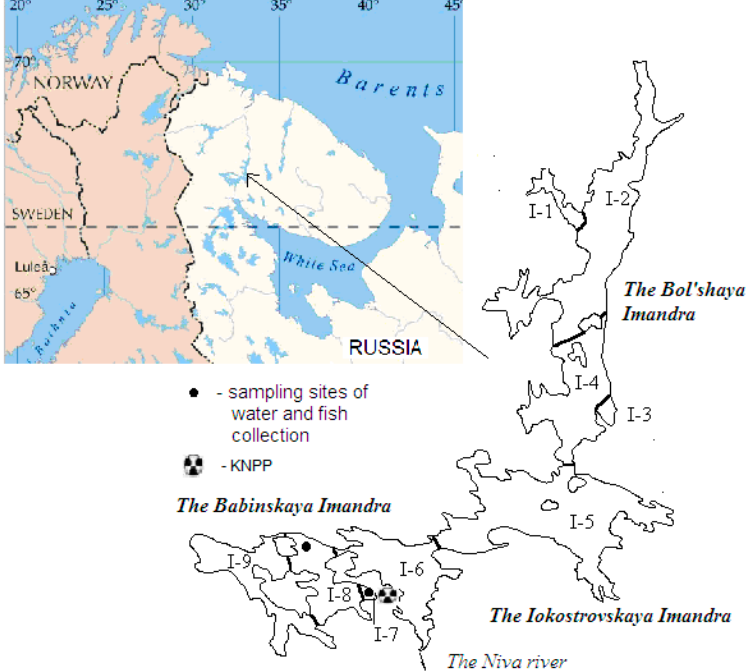
Figure 2. Map with the zoning of Lake Imandra.